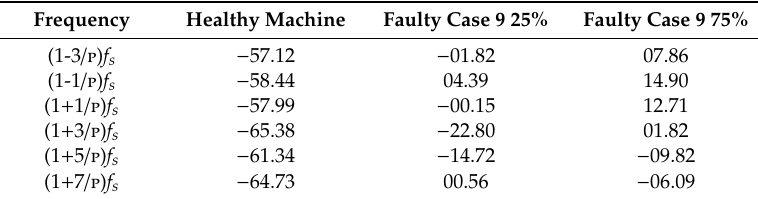
Table 9. Current harmonic components comparison due to case 9 (in dB).